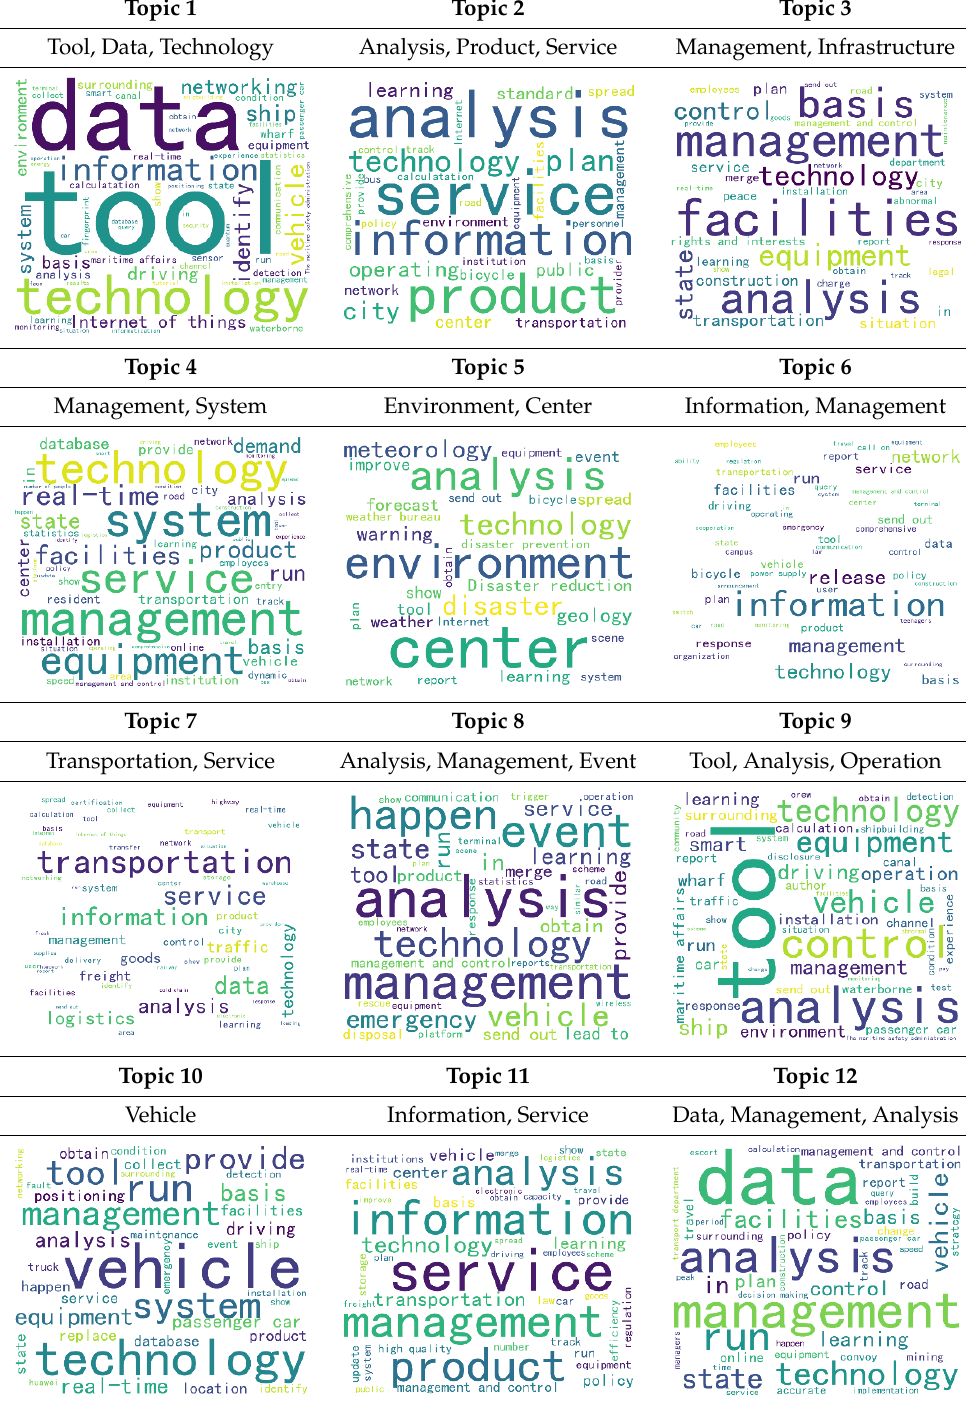
Table 3. Description of function domains.